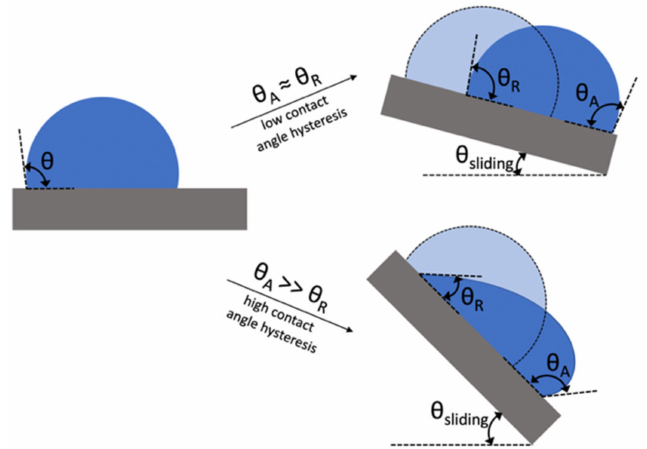
Figure 6. Schematic illustration of the dynamic (i.e., advancing and receding) contact angles resulting from the motion of a water drop on a tilted surface. A larger contact angle hysteresis (i.e., difference between θ A and θ R leads to requiring a larger tilt to initiate drop